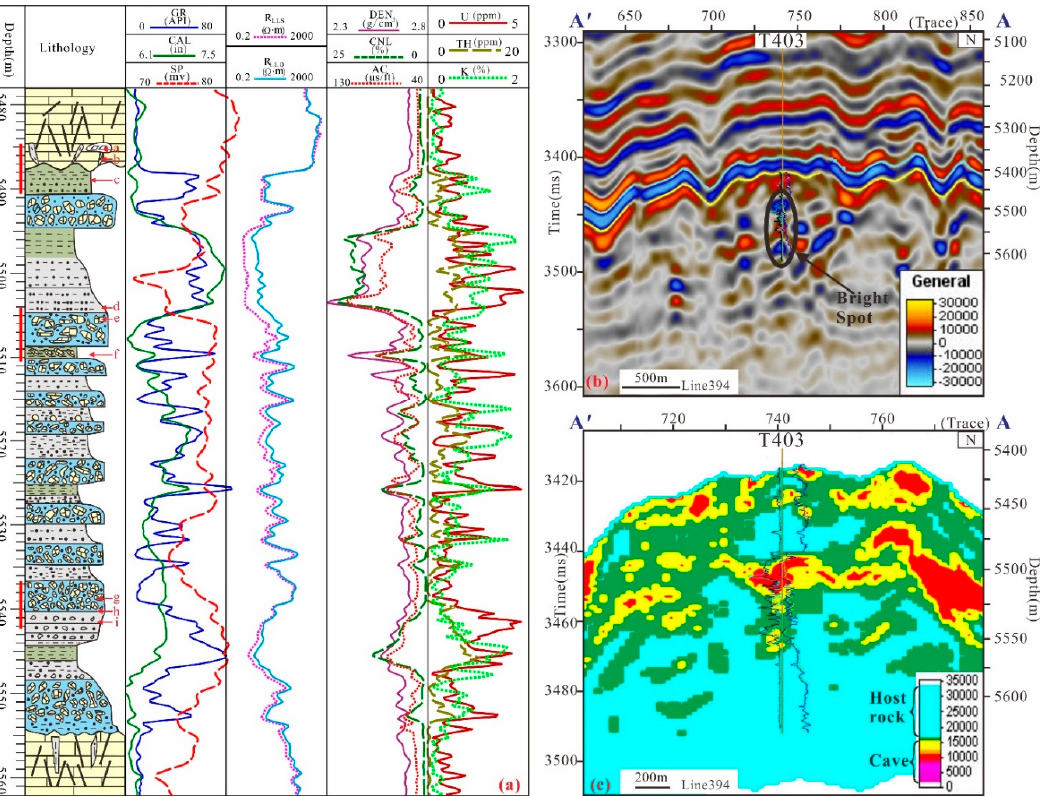
Figure 4. Comprehensive characteristics of the core, well logging, and seismic profiles of the Ordovician paleokarst reservoirs in Well T403, see profile location A ‐ A’ in Figure 1d. ( a ) Well T403 core section comprehensive core map, showing a variety of filling inside the cave; ( b ) Well T403 amplitude seismic profile shows that the well is drilling a typical “Bright Spot”; ( c ) Well T403 wave impedance profile shows the differences between caves and host rocks.